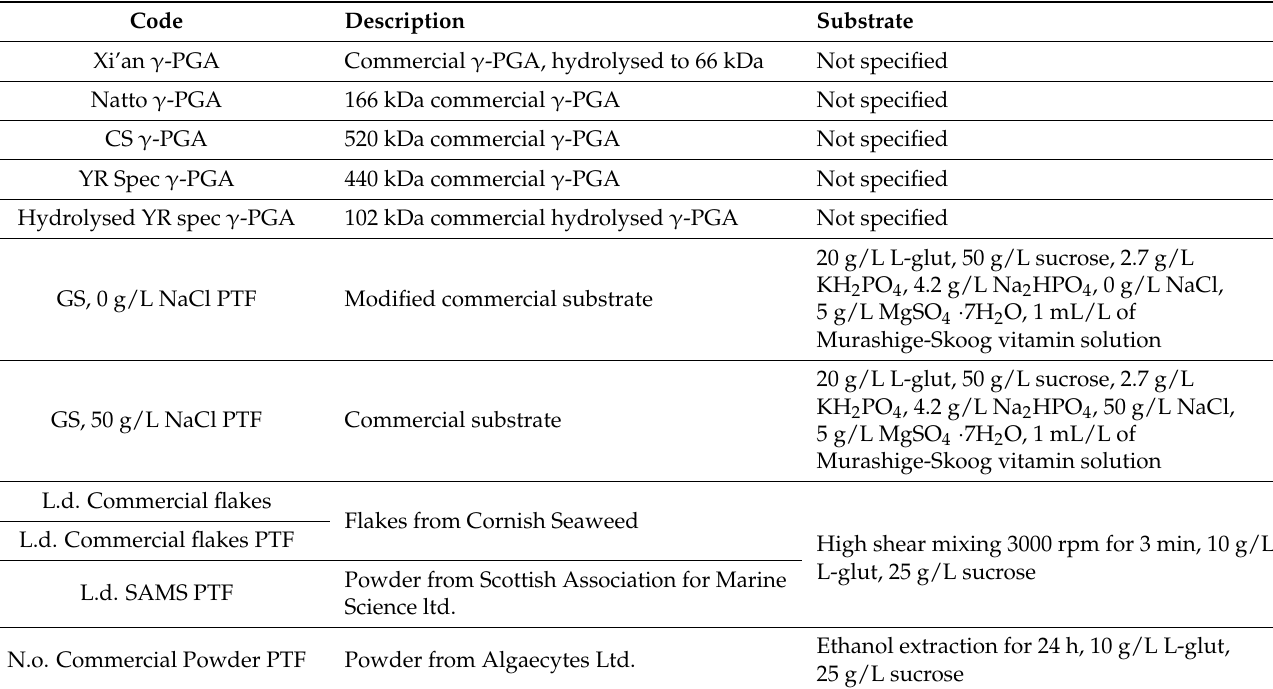
Table 1. Summary of γ -PGA sample codes and relevant